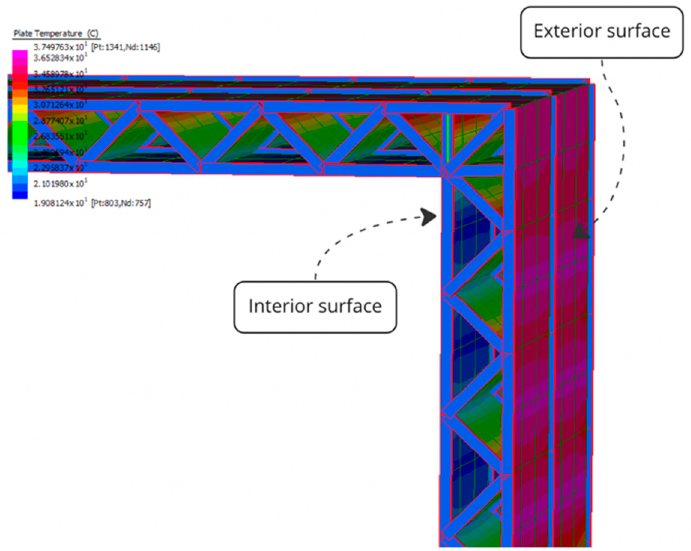
Figure 13. Distribution of temperature between the interior and exterior surface.